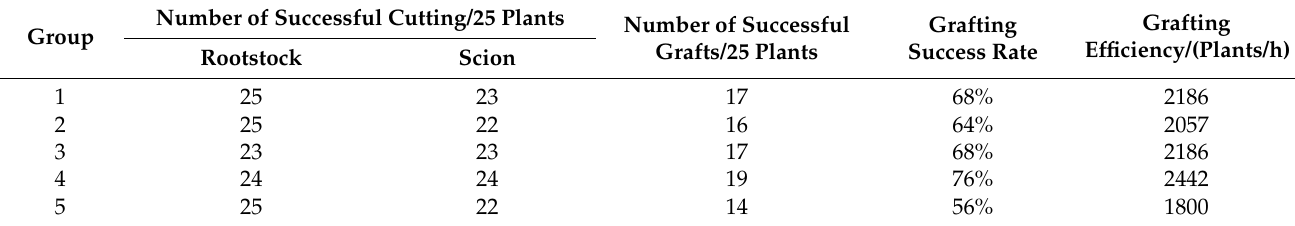
Table 4. Grafting test